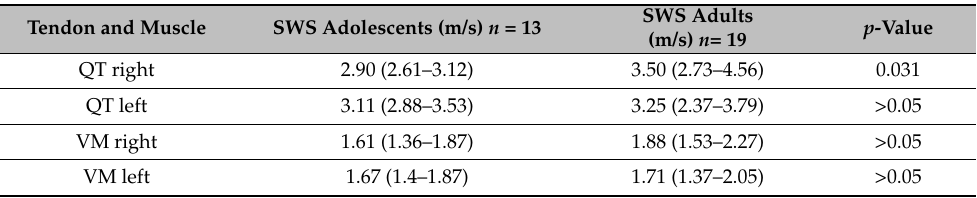
Table 1. Mean shear wave speed (SWS) of the quadriceps tendon and medial vastus muscle in professional adolescent and adult athletes (continuous variables not following a normal distribution